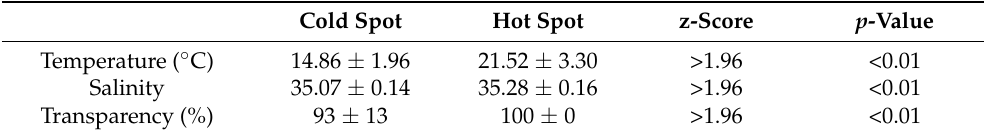
Figure 10. Results of the hot spot (Getis–Ord Gi*) analysis on Cassiopea andromeda records in Cala in relation to the environmental parameters ( a ) temperature, ( b ) salinity, and ( c ) transparency: blue and purple triangles indicate hot spots (high values) and cold spots (low values), respectively; yellow triangles indicate records with non-significant index values. Table 3. Average ± S.E. for temperature, salinity, and transparency corresponding to hot and cold spots, with the z-score and p -value.